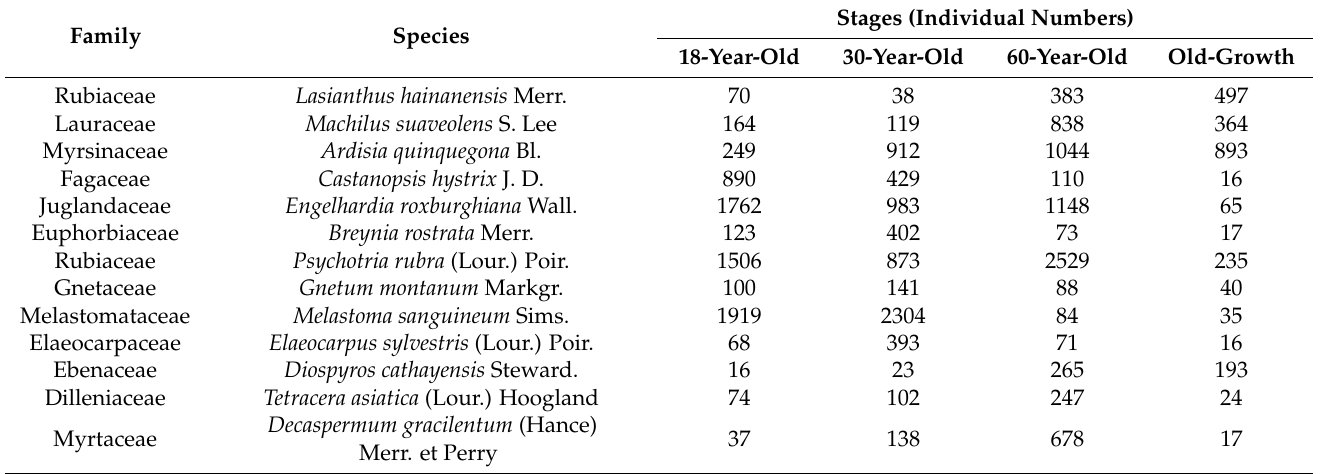
Table 1. The 13 co-existing species among all successional stages and their information (species names, individual numbers of each successional